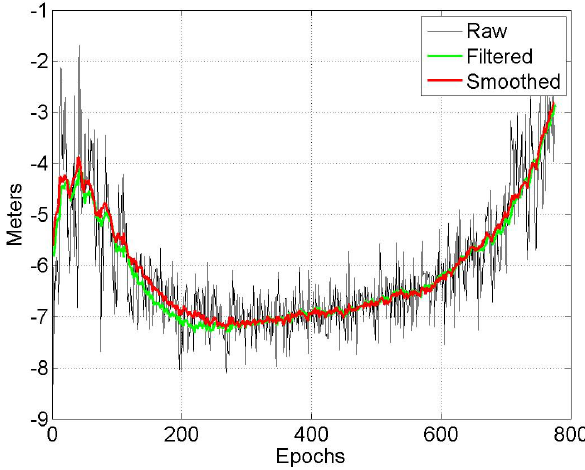
Fig. 3. Ionospheric propagation